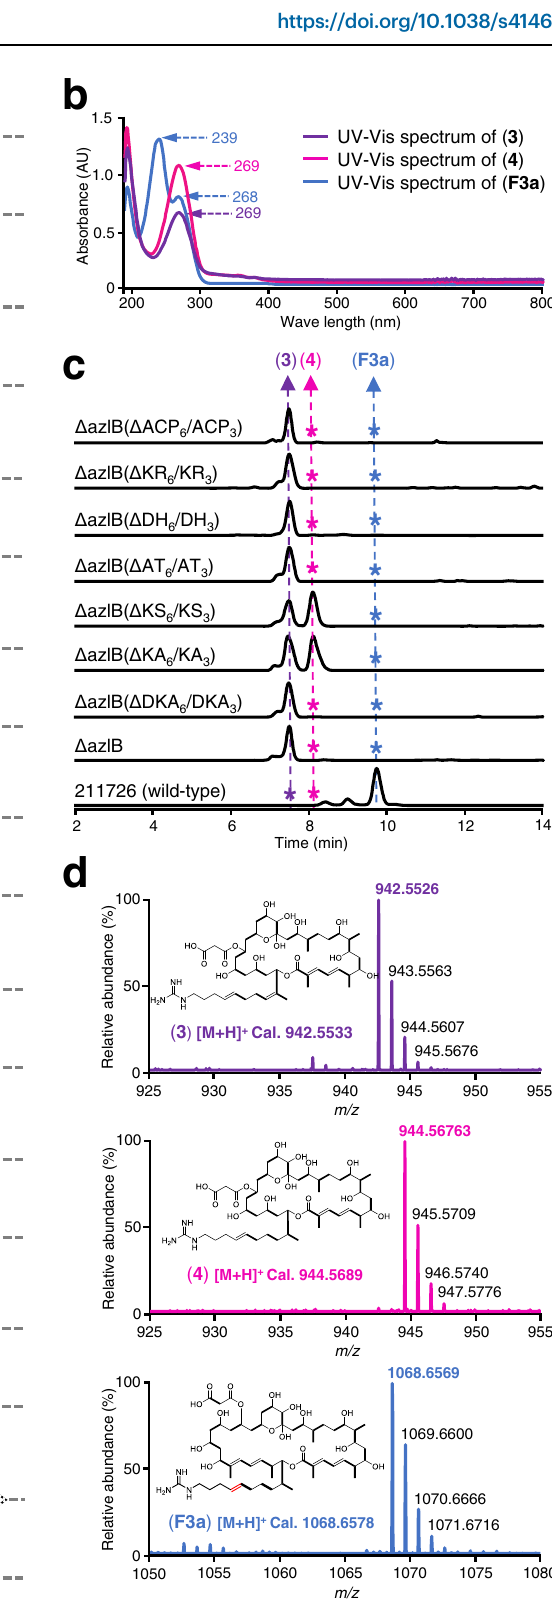
Fig. 5 | Products analysis of domain replacement strains based on Δ azlB mutants. a Diagram for domain replacements in Δ azlB mutants. The dotted